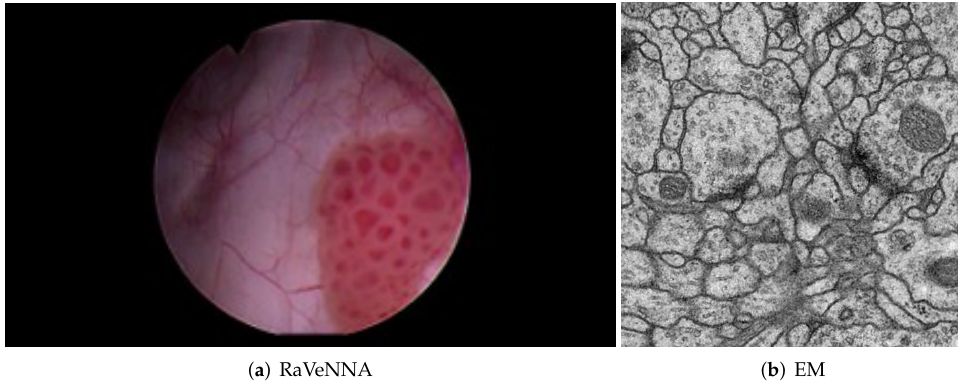
Figure 5. Biomedical